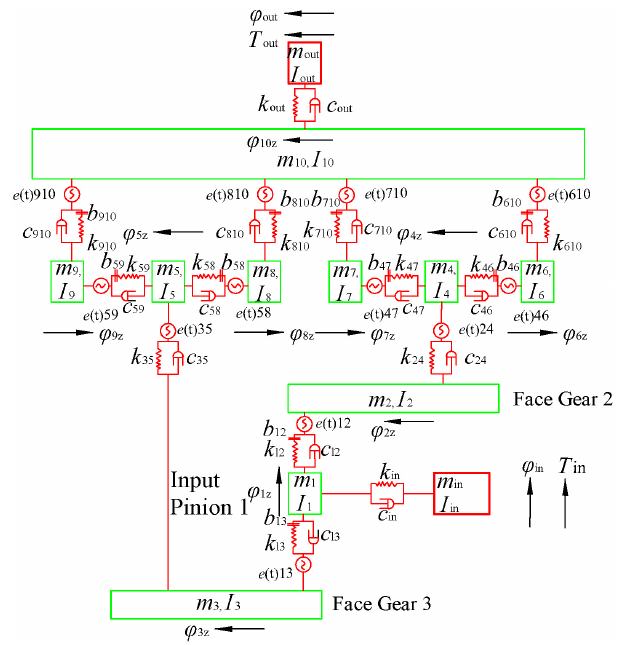
Figure 2. Torsional dynamic model of the system.